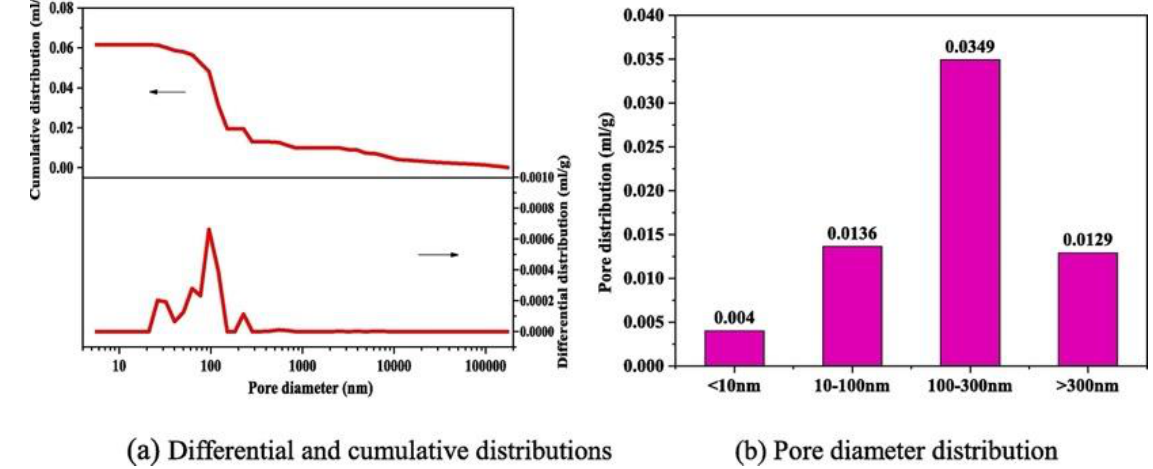
Figure 14. Pore structure of PMG-80 obtained by MIP [79].